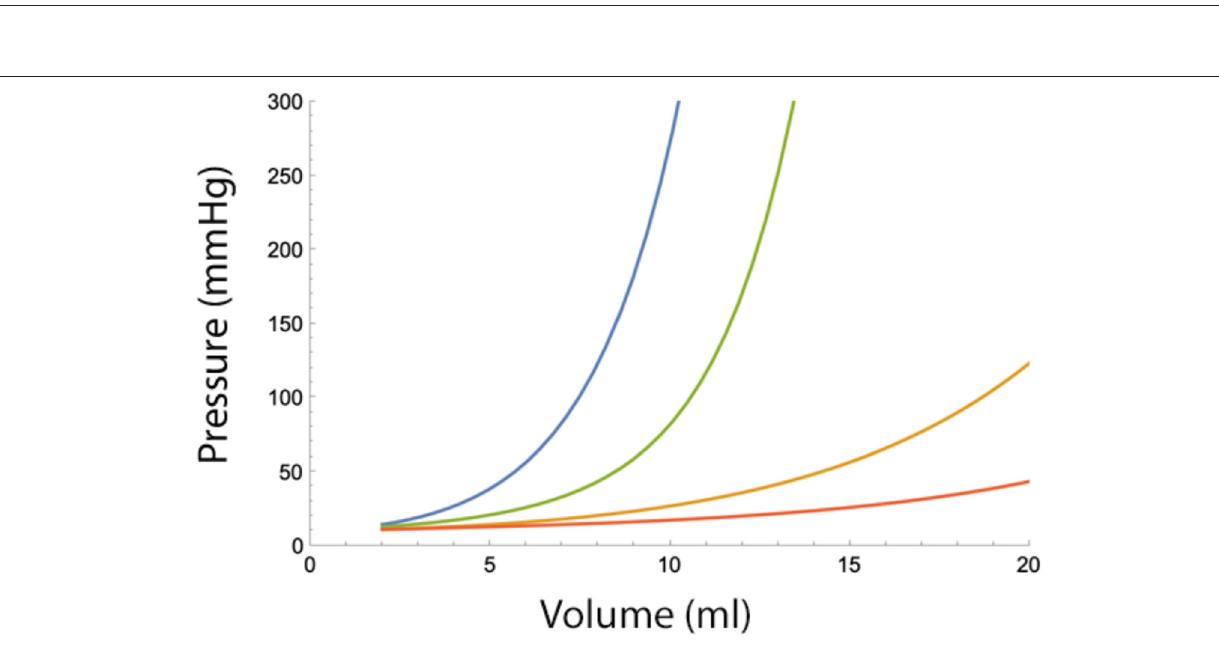
FIGURE 3 | Epidural pressure after two epidural fluid bolus injections, 1 or 5min apart, for severe (i.e., A conditions (i.e., A 10ml and B 10 ml/min). Blue 1min apart, severe conditions. Green = = − conditions. Red 5min apart and moderately severe −